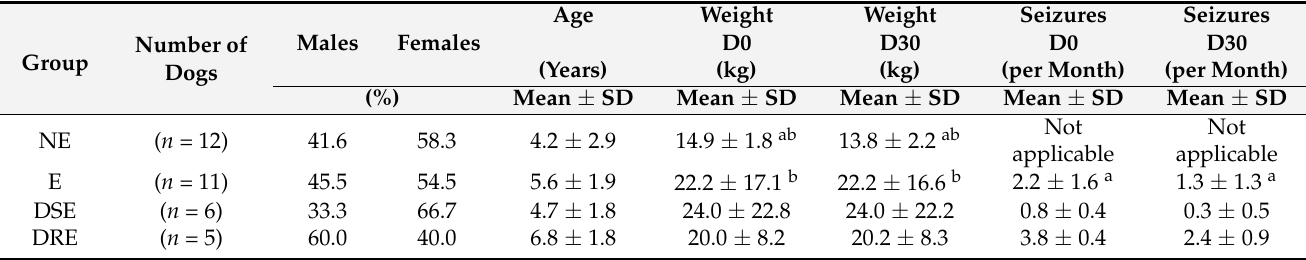
Table 1. Demographic and clinical data in the studied canine